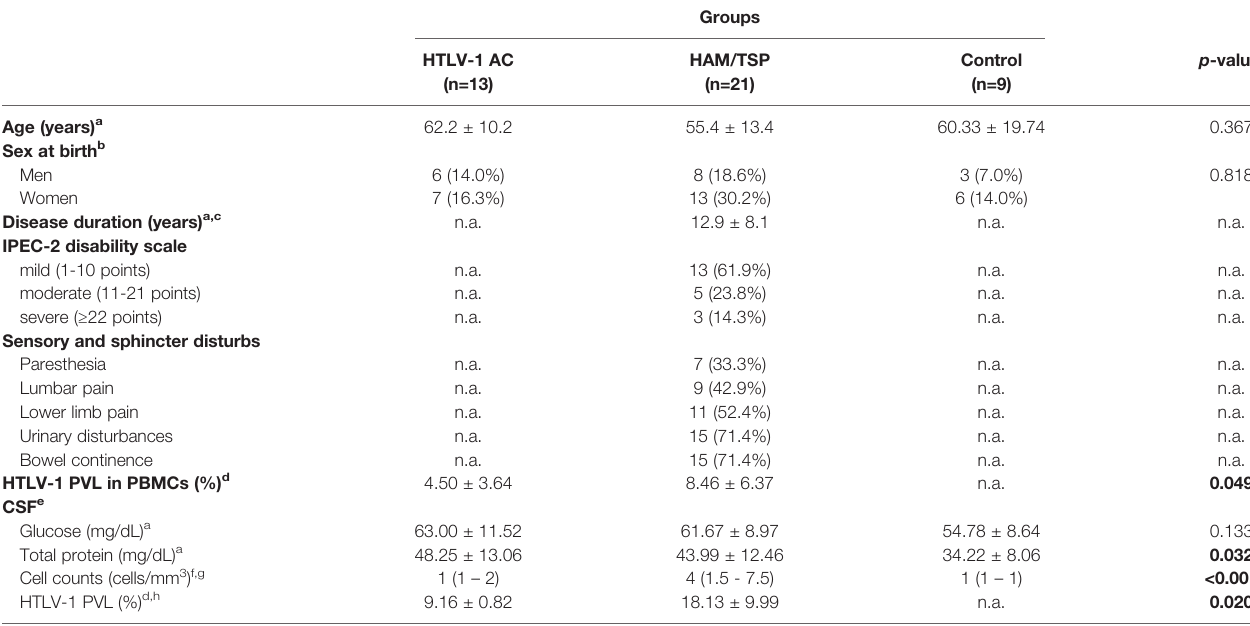
TABLE 2 | Characterization of the study population.